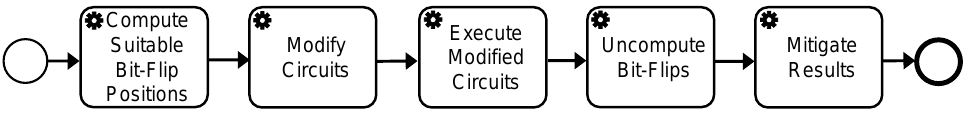
Figure 6. Exemplary REM workflow fragment for a bit-flip-based circuit modification